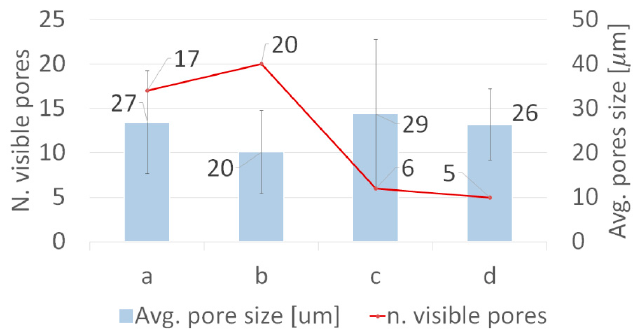
Figure 5. Total pore counting analysis of a–d samples by optical microscopy at 200 × magnification: number of visible pores and average pore size.